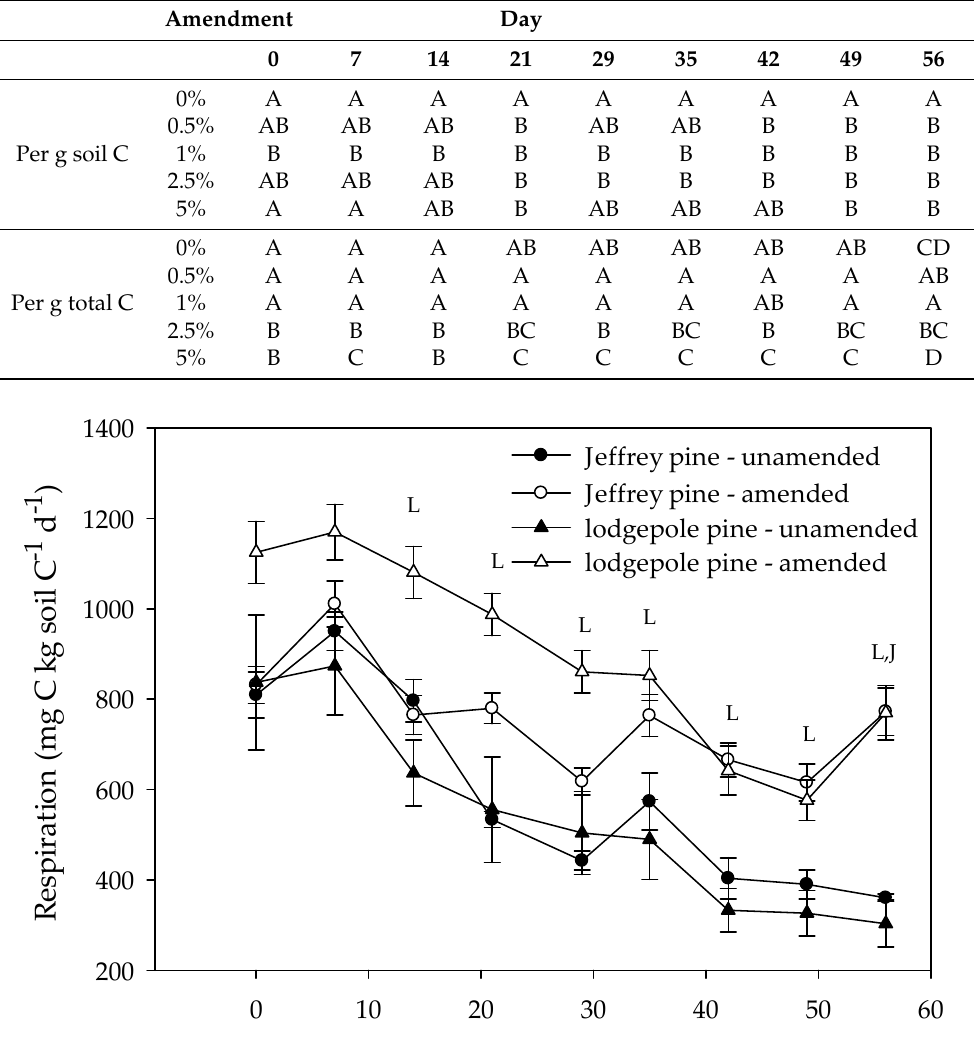
Table 3. Results from post-hoc tests assessing differences in microbial respiration between amendment levels at each measurement time. Day 0 represents the first measurement day following a one-week pre-incubation period. Different letters indicate significant ( p < 0.05) differences between amendment levels for each measurement day.